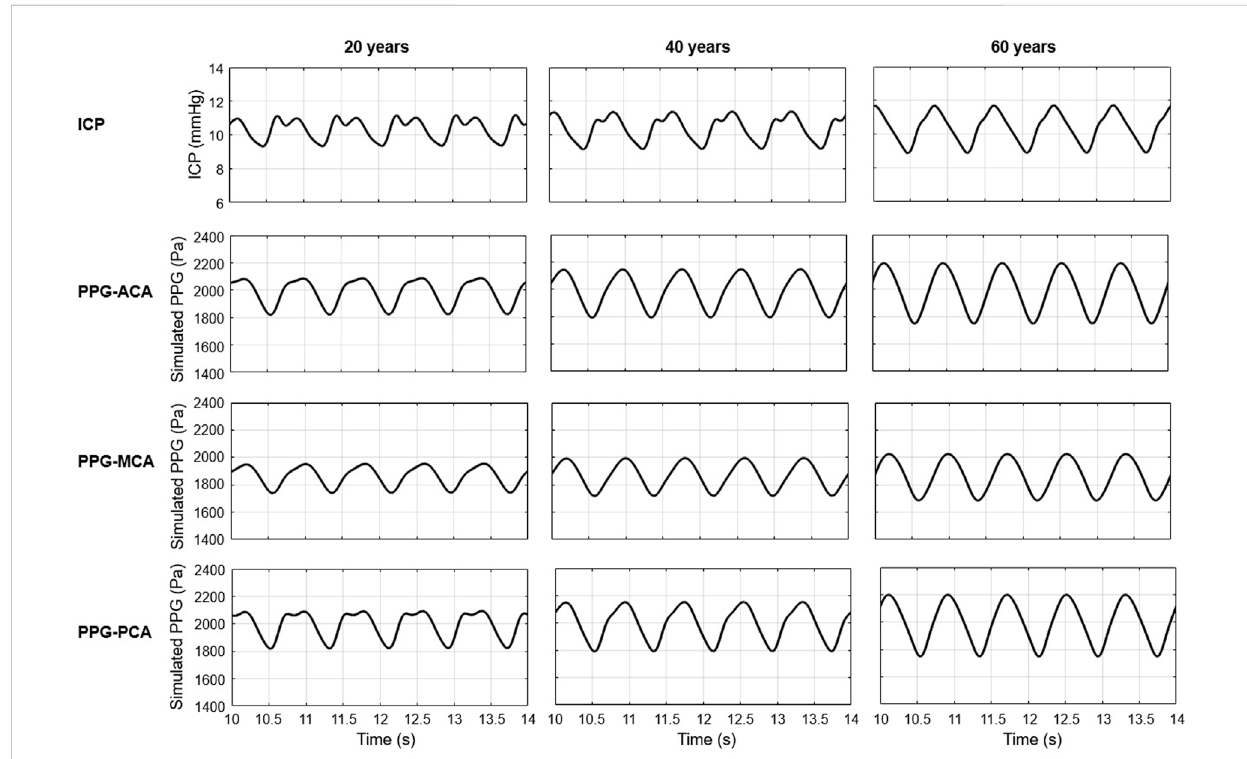
FIGURE 6 Simulated ICP and PPG waveforms during fi ve cardiac cycles (10 – 14s) in 20, 40, and 60 years old healthy male subjects with normal intracranial